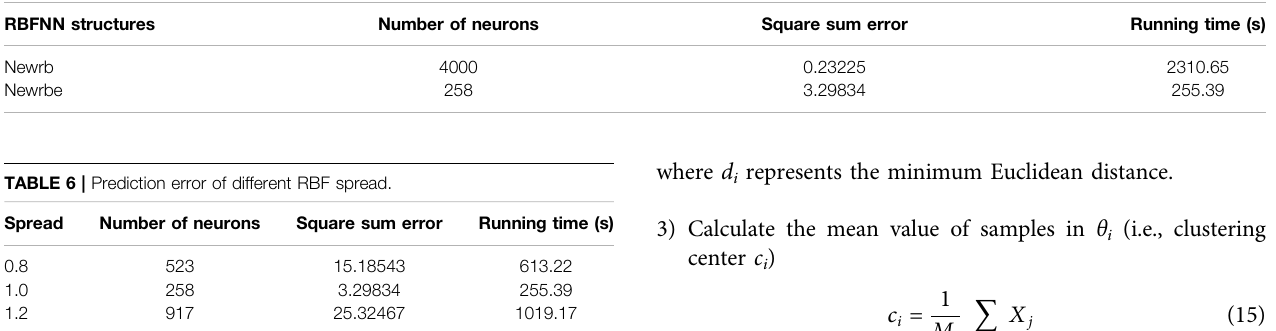
TABLE 5 | Prediction error of different RBFNN structures.